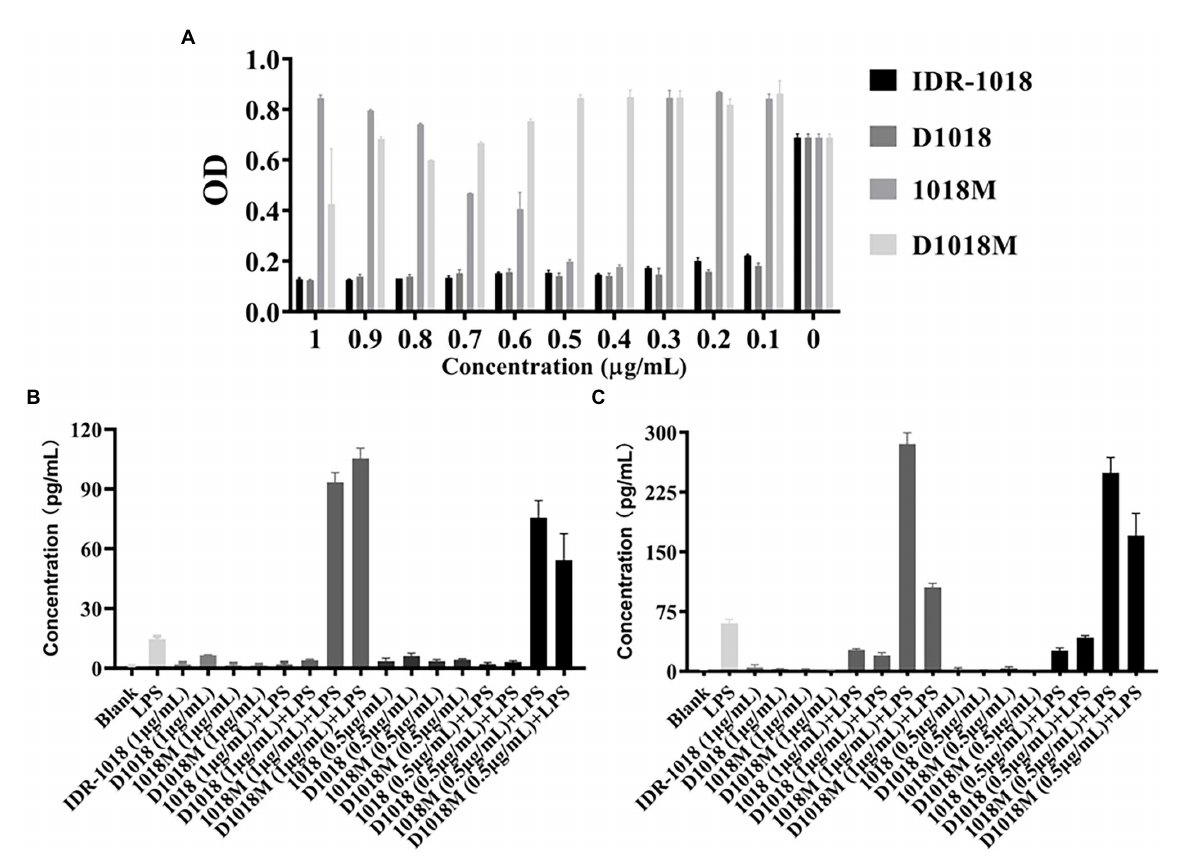
FIGURE 4 LPS binding affinity of peptides and the effects of binding to LPS-induced proinflammatory response. (A) LPS Binding affinity of IDR-1018, 1018M, D1018, and D1018M. Effect of IDR-1018, 1018M, D1018, and D1018M on IL-6 (B) and TNF- α (C) produced by RAW 264.7